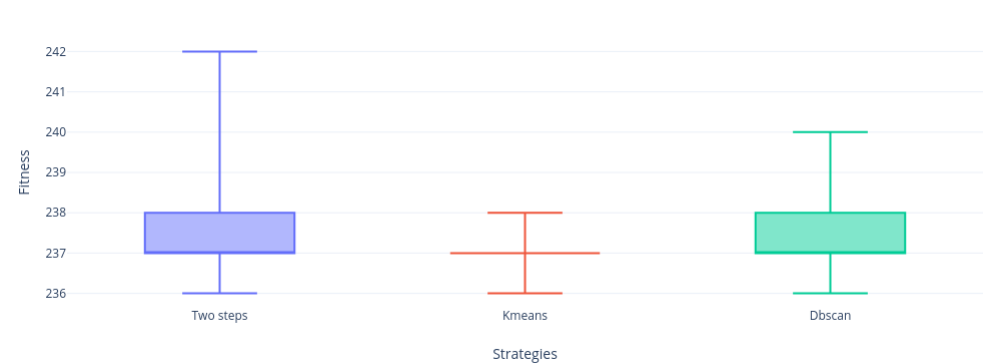
Figure 10. Instance 6.5 distribution.